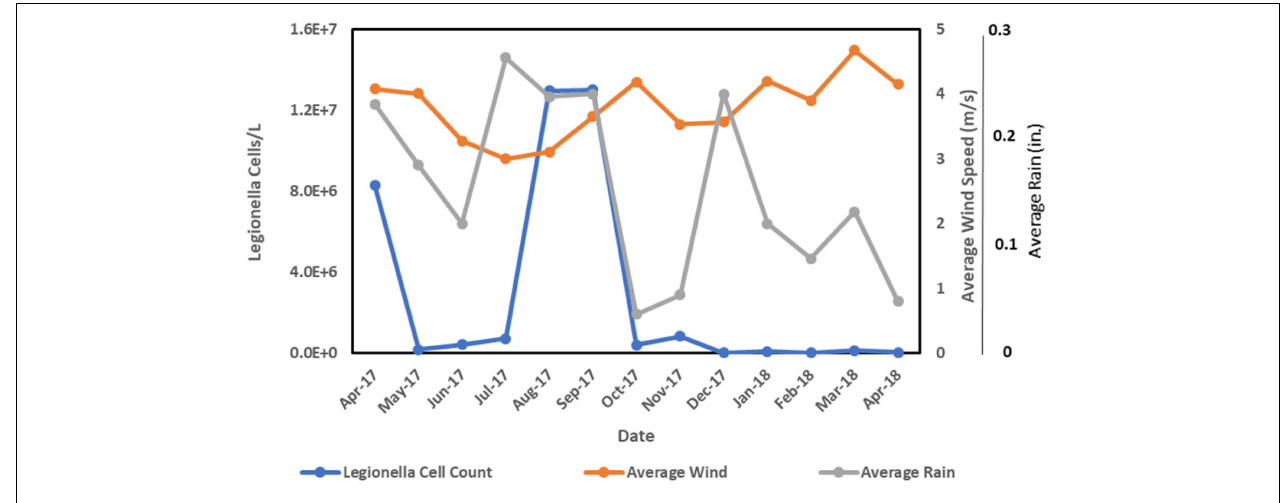
FIGURE 5 | Average wind and rain effects on Legionella concentrations for the 785A/2A cooling